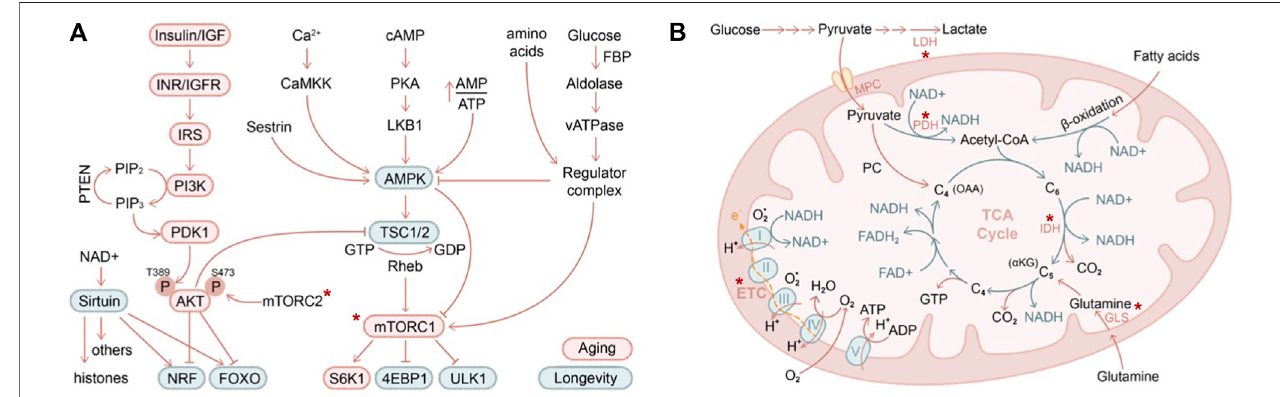
FIGURE 3 | Nutritional and metabolic regulation of skin aging (A) IIS (insulin/insulin-like growth factor) and AMPK/mTOR are two major pathways in regulating nutrients and metabolism that have been described in contributing to organismal aging (red circle) and longevity (green circle). Asterix indicates components of these pathways that have been demonstrated to contribute to skin aging (B) Mitochondrial biology is closely intertwined with aging biology. Highlighted in red are several key genes that have been shown to regulate skin stem cell aging in vivo . LDH, lactate dehydrogenase; PDH, pyruvate dehydrogenase; MPC, mitochondrial pyruvate carrier; GLS, glutaminase; IDH, isocitrate dehydrogenase (converting isocitrate into alpha-ketoglutarate). Asterix indicates components of these pathways that have been demonstrated to contribute to skin